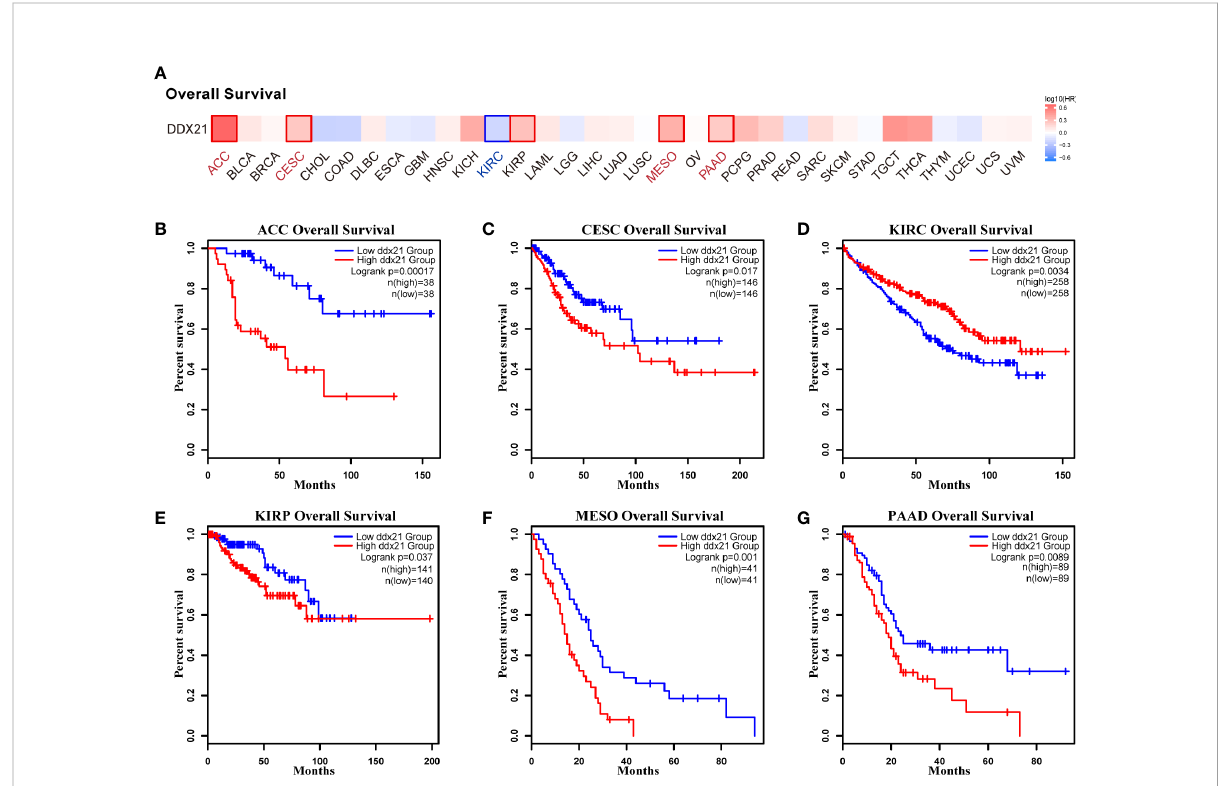
FIGURE 3 Correlation between DDX21 expression and overall survival (OS) in patients with different TCGA tumor types. GEPIA2 was used to build a survival map (A) and conduct overall survival analyses (B – G) . The survival map and Kaplan – Meier plots with signi fi cant results are displayed. The 95% con fi dence intervals of OS are indicated by red and blue dotted lines for high and low DDX21 expression groups,